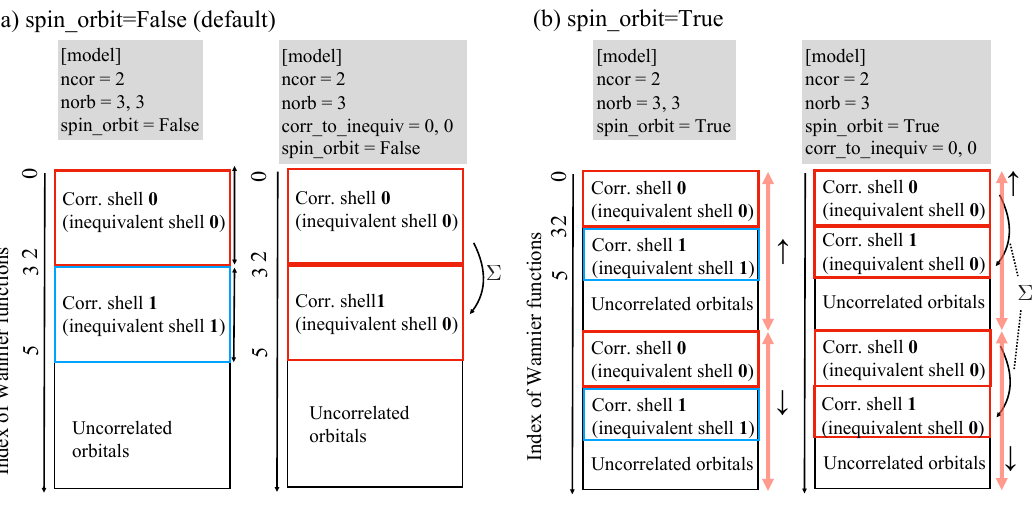
Figure 5: Shell structure of Wannier90 file with (a) spin_orbit = True and (b) spin_orbit = False.